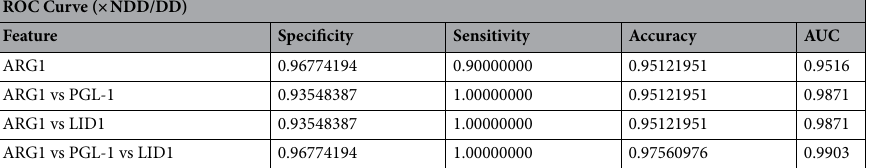
Table 2. Specificity, sensitivity and, accuracy of the use of arginase activity to identify contacts more prone to develop leprosy. ARG1 = arginase 1, PGL-1 = Phenolic glycolipid, LID-1 (the fusion protein product of the ml0405 and ml2331